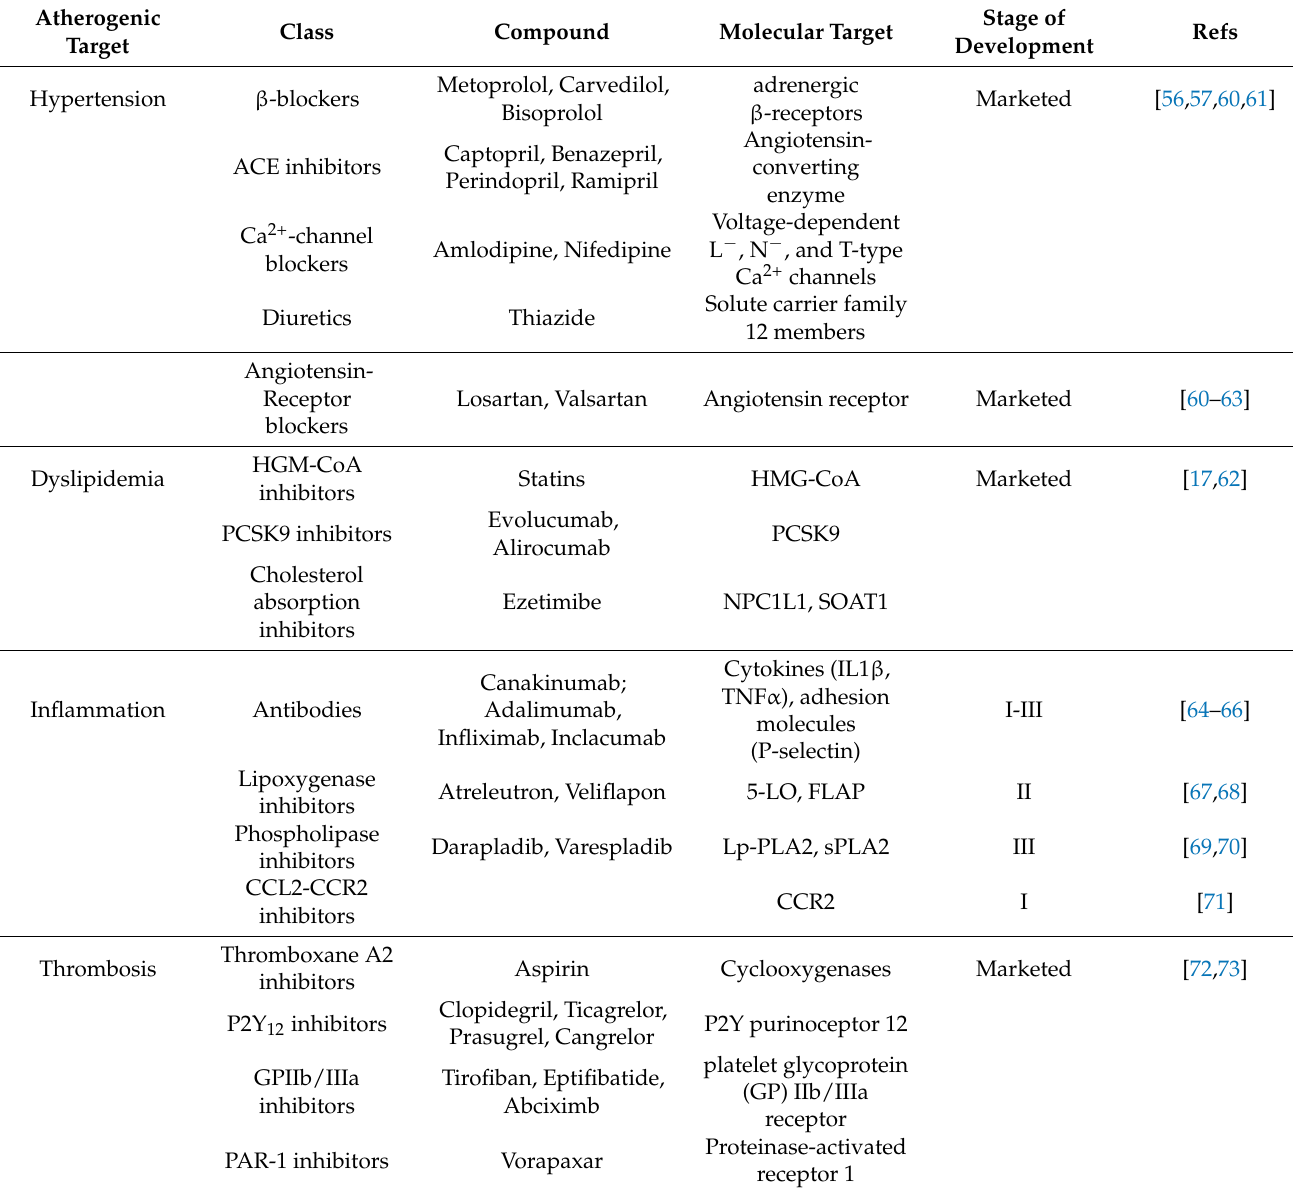
Table 1. Current and experimental anti-atherogenic